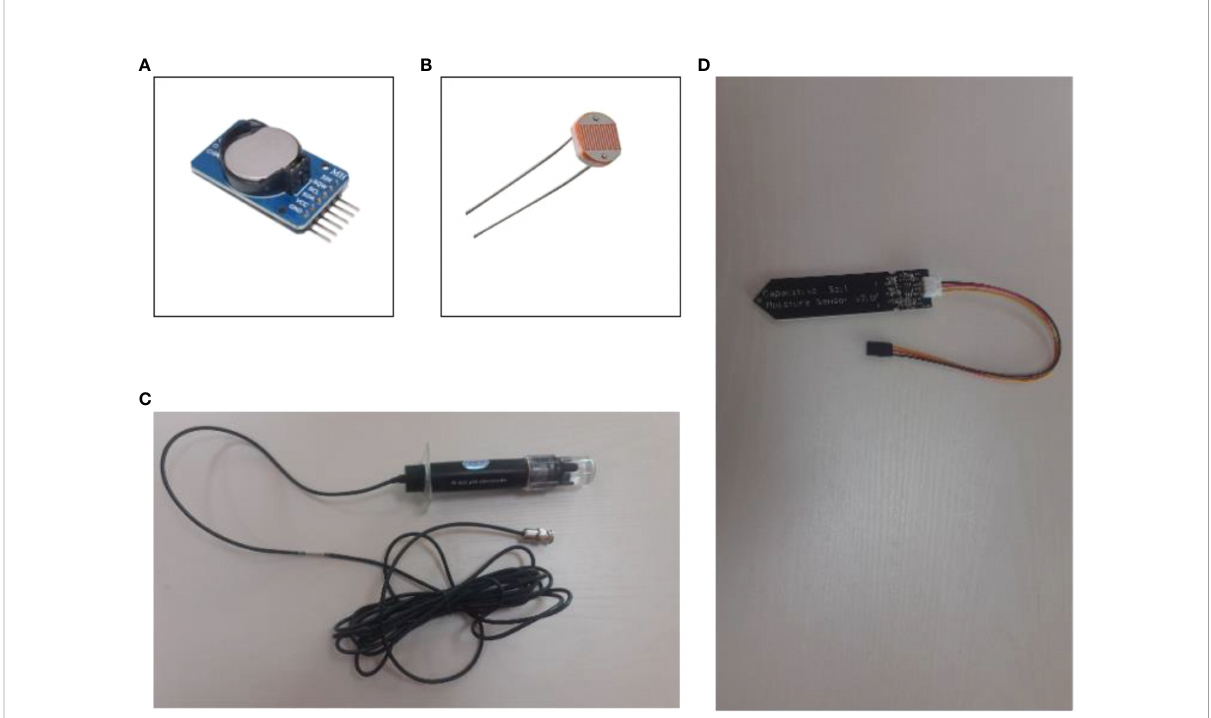
depicts all the different components, including sensors and (cid:129) Figure 4A shows the DS3231 RTC module, a real-time clock module that uses DS3231 IC as its backbone. It contains a backup battery mounted at the back of the module to keep track of time even in the absence of a main power source, with a chip capable of automatically switching between the main and backup power source as necessary (Suryawinata et al., 2017). (cid:129) Figure 4B shows an LDR sensor that works on the photoconductivity principle, with resistance varying according to light intensity. When the LDR connects with the 5V, it gives an analog voltage that varies depending on the input light intensity (Salim et al., 2015). (cid:129) Figure 4C depicts an industrial-grade analog pH sensor made from a sensitive glass membrane with low impedance. It can be used in pH measurements with